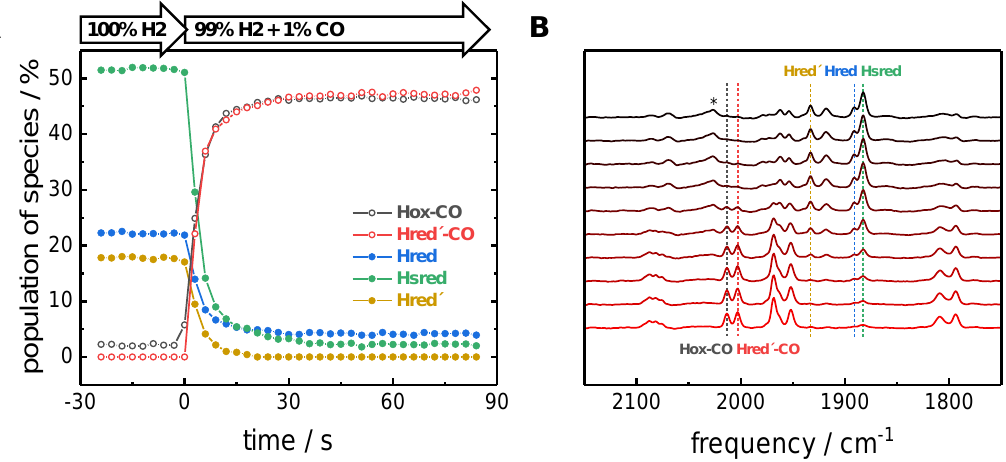
Figure 7. CO inhibition of pre-reduced HYDA1. Kinetic traces in ( A ) and corresponding FTIR spectra in ( B ). [FeFe]-hydrogenase was first exposed to 100% H 2 to accumulate the reduced species Hred, Hsred, and Hred´. No external potential was applied. Upon injection of 1% CO into the gas stream, the H-cluster rapidly forms about equal populations of Hox-CO and Hred´-CO. While Hred´ is lost within ~10 s, Hred and Hsred decrease to reach a stable population of around 5% after ~1 min. * The high-frequency band at 2026 cm − 1 has been to assigned to Hsred and is unrelated to the CO-inhibited species.